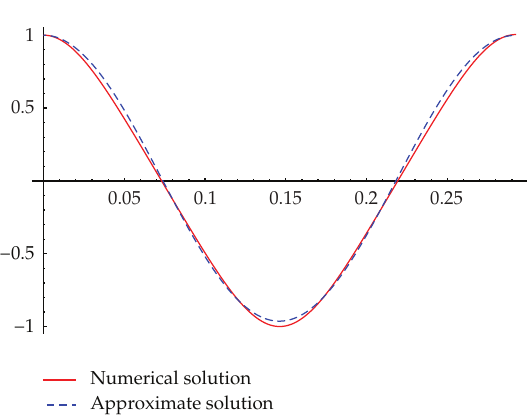
Figure 1: Comparison between the numerical solution of (cid:2) 1.1 (cid:3) and the approximate solution (cid:2) 3.4 (cid:3) for A (cid:9) 1, (cid:9) 200, k (cid:9) 1000, q (cid:9) 0 . 1, ω m (cid:9) 2, k 1 2